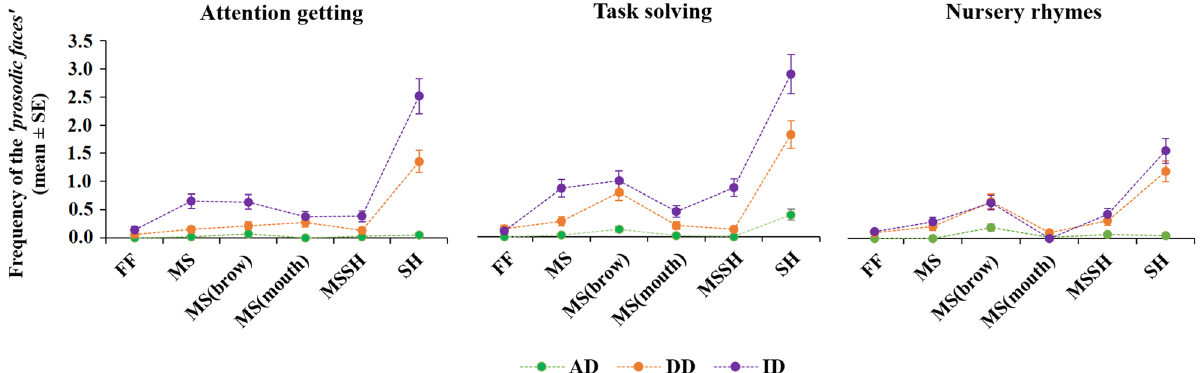
Figure 2. Mean (+ SE) frequencies of the ‘prosodic faces’ toward the three partners and situations. AD adult- directed, DD dog-directed, ID infant-directed. FF fish face , MS mock surprise , MSSH mock surprise + special happy , SH special happy